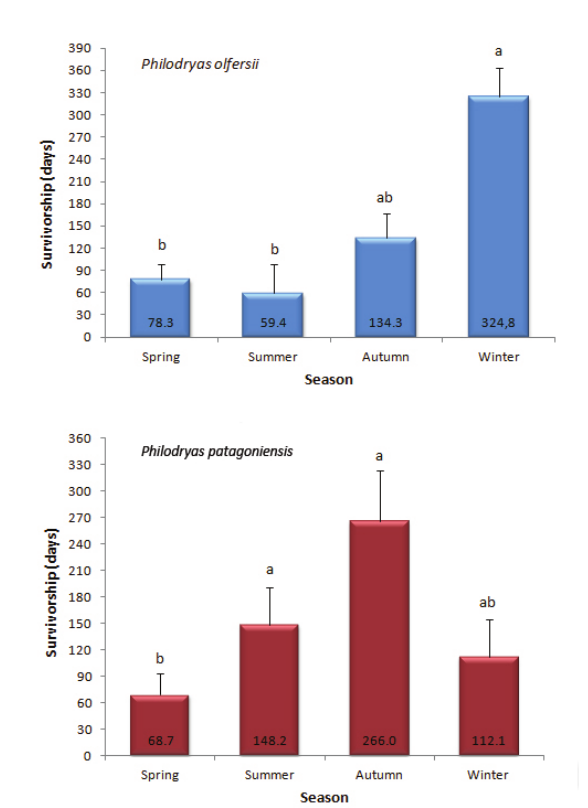
Figure 4. Mean survival against capture season for female Philodryas olfersii and Philodryas patagoniensis maintained in captivity for venom extraction. Seasons with the same letter are not significantly different (Tukey’s post-hoc test, α = 0.05, a > b ). Error bars represent standard error.